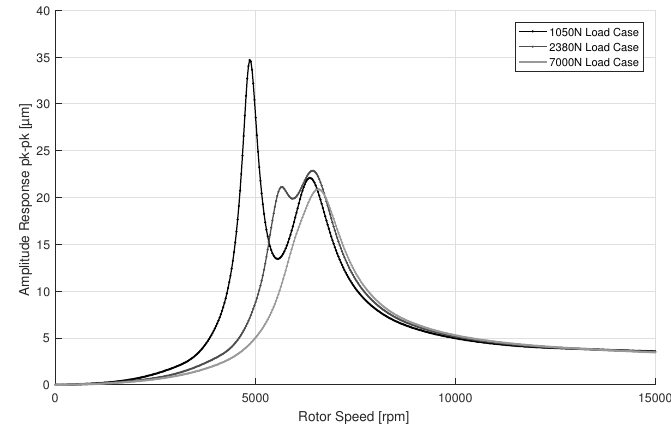
Figure 7. Amplitude vibration response plot for the selected quasi-static load